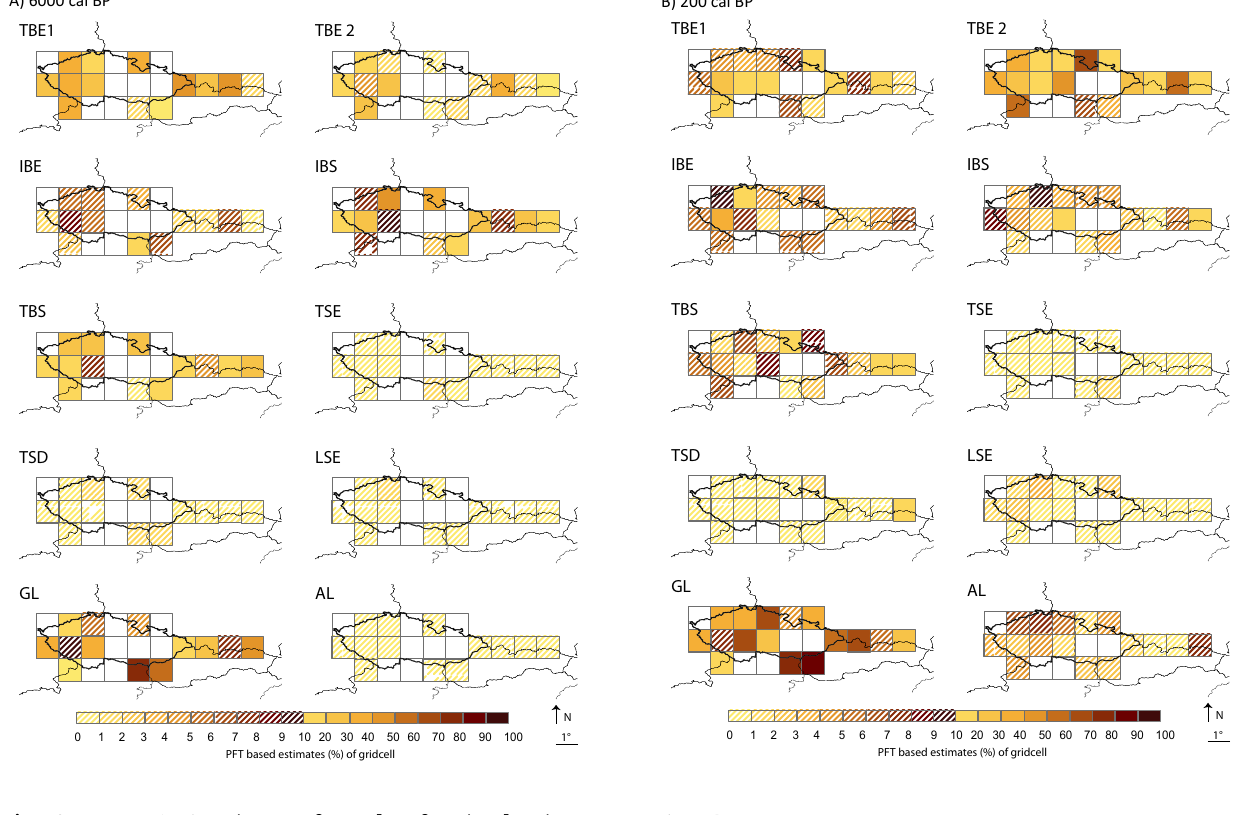
Fig. 10a. REVEALS estimates of ten plant functional estimates (PFTs) for the Czech Republic at 6000BP (A) and 200BP (B) us- ing the PALYCZ pollen database (Kuneˇs et al., 2009) and following the LANDCLIM project’s protocol. The definition of the PFTs are found in Table 1. In this visualization of the results, the zero values (no occurrence of a PFT) are not distinguised from values > 0% up to 1%. Note the large difference in the open-land PFTs between 6000 and 200BP, with up to 80% grassland (GL, grasses and herbs) and up to 9% agricultural land (AL, cereals) at 200BP, compared to maximum 50% grassland (except in the SE) and ≤ 1% agricul- tural land at 6000BP. A thorough discussion of these results will be published elsewhere (Mazier et al.,